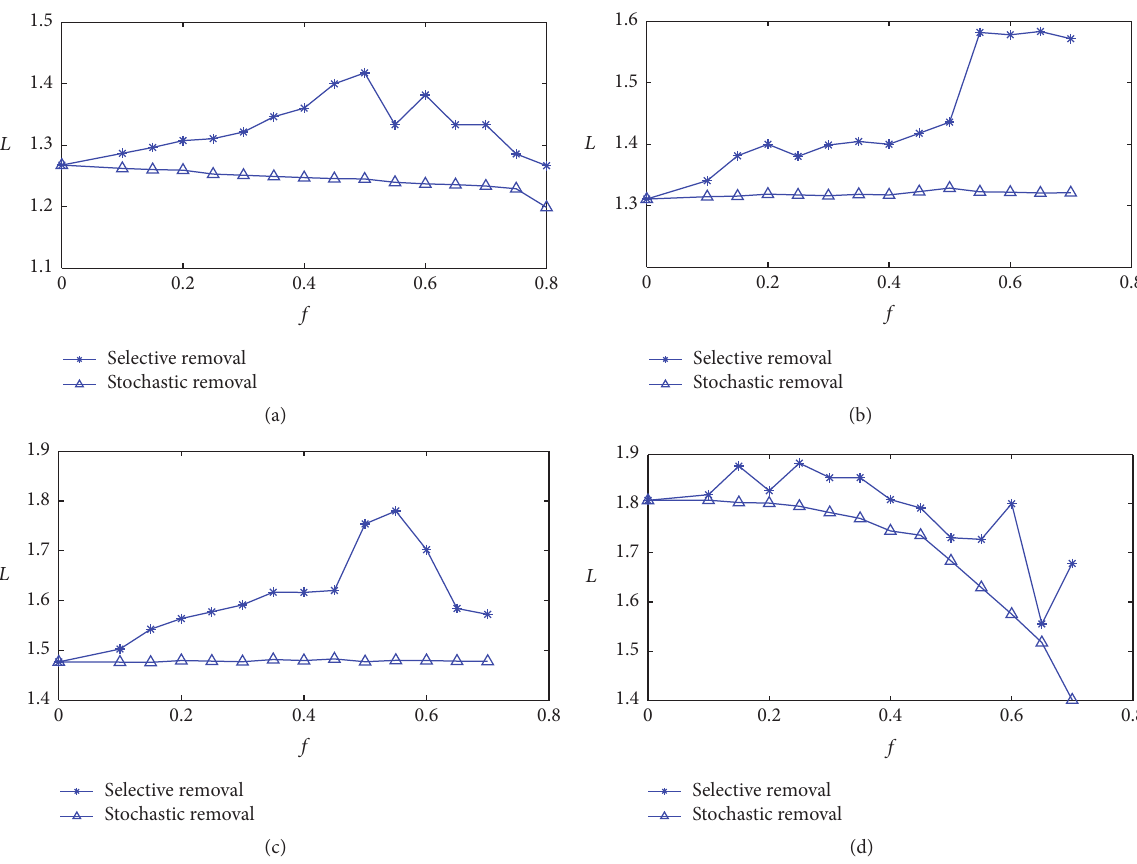
Figure 9: The average path length 𝐿 versus 𝑓 when (a) 𝜃 = 0.25 ; (b) 𝜃 = 0.3 ; (c) 𝜃 = 0.35 ; (d) 𝜃 = 0.4 . With an increase of 𝑓 , we find that the average path length L under selective removal is always larger than that under stochastic removal. These four subgraphs are all robust. If the thresholds equal other values in interval [0.25, 0.4], the general rules of topological stability are not changed. So we only demonstrate aforesaid four cases.